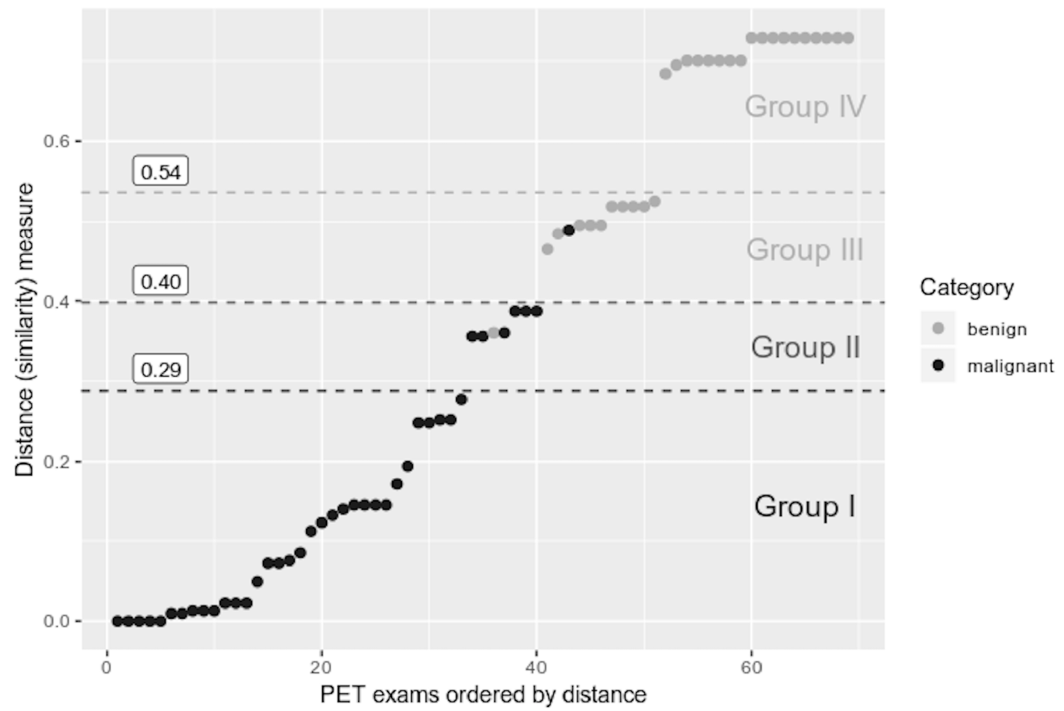
Figure 13. Values of synthetic variable based on GDM2 for each analysed hypermetabolic nodule in PET images.